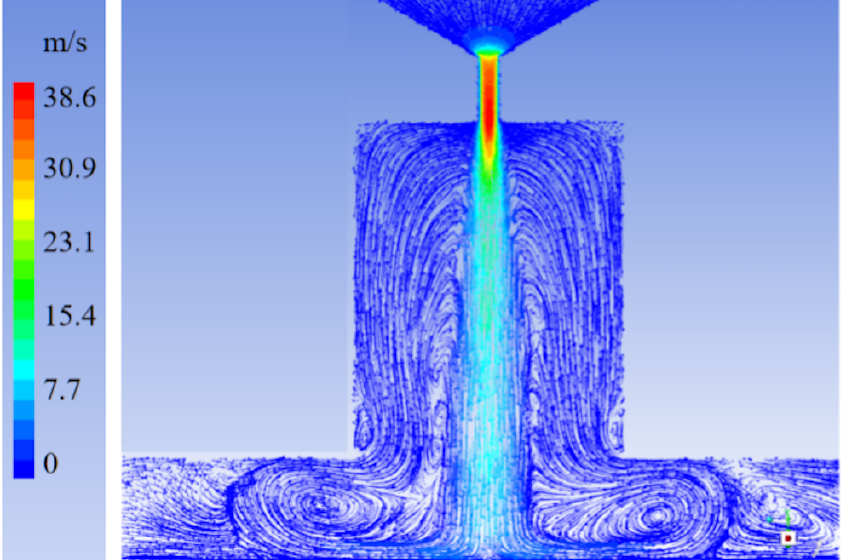
Figure 11. Flow pattern of simplified model at recess inlet.